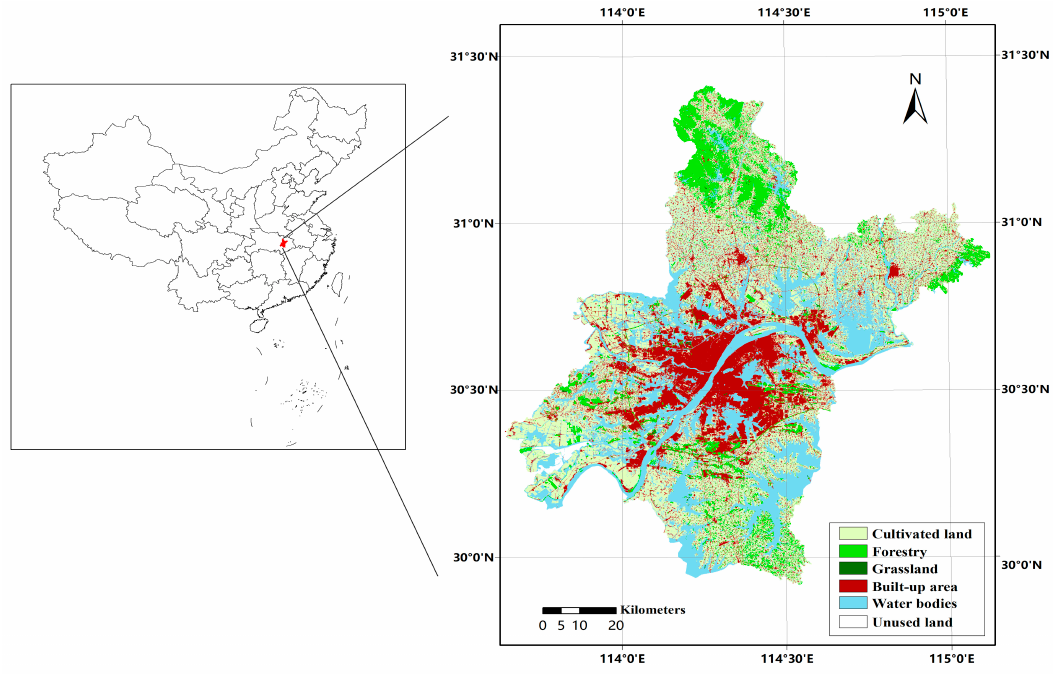
Figure 1. Location of the study area and its land use map of 2012.